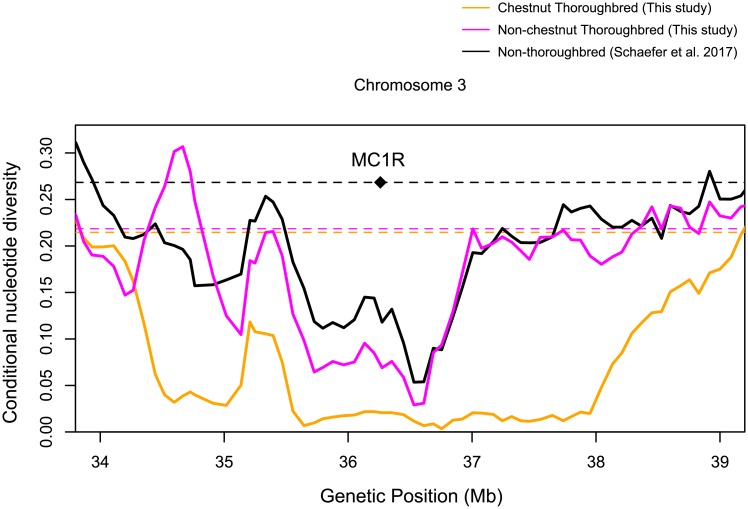
Putative selective sweep around the MC1R locus.The distributions based on the SNPs from the 94 Thoroughbreds with chestnut coat color, 276 Thoroughbreds with non-chestnut coat color of this study, and 287 non-Thoroughbreds of [19] are shown in orange, magenta, and black, respectively. The distributions are based on values calculated for each sliding window of 400 kb with an increment of 80 kb. The average values for each chromosome are shown by horizontal dotted lines.